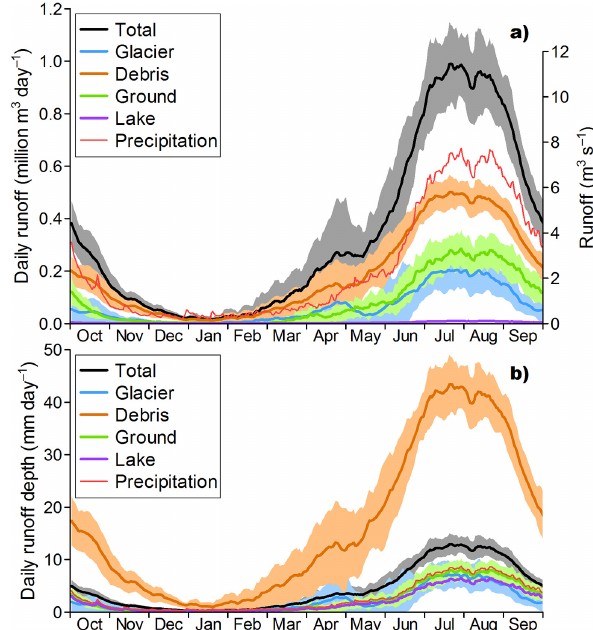
Figure 9. Seasonal cycles of (a) daily runoff and (b) daily runoff depth of the Tsho Rolpa Glacial Lake–Trambau Glacier basin cal- culated for the period 1979–2007 (28 years). Shading denotes in- terannual variability obtained for the same period. The interannual variability of runoff depth from the lake is not shown for better vis- ibility in (b) . Also shown is the seasonal cycle of precipitation av- eraged for the whole basin (thin red